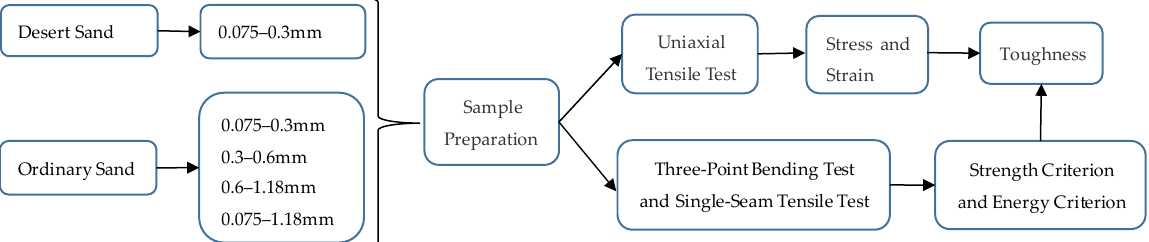
Figure 1. Schematic flow diagram of this study.